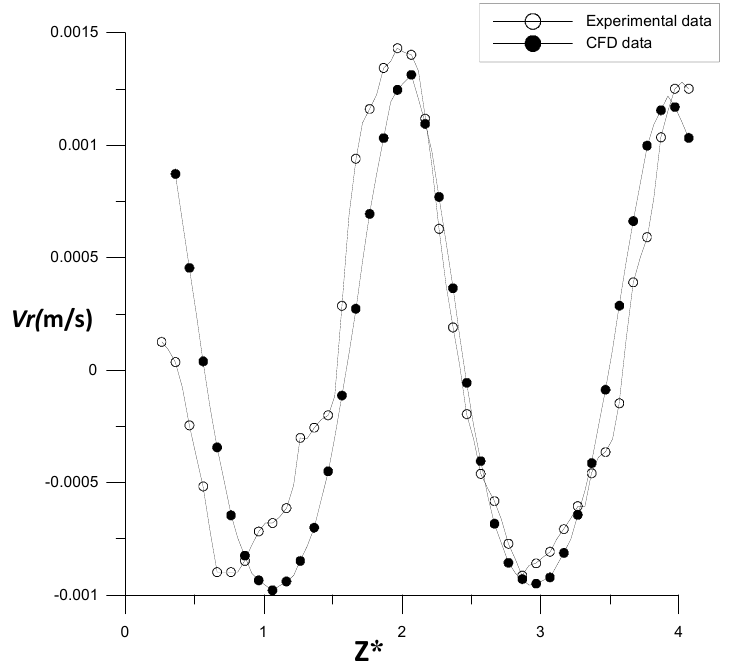
Figure 9. Radial velocity profile of PIV and